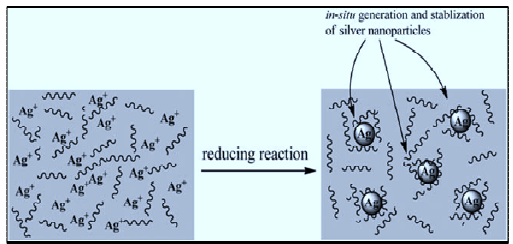
Fig. 7. Silver nanoparticles formation and stabilization by the in situ generation mechanism [18].